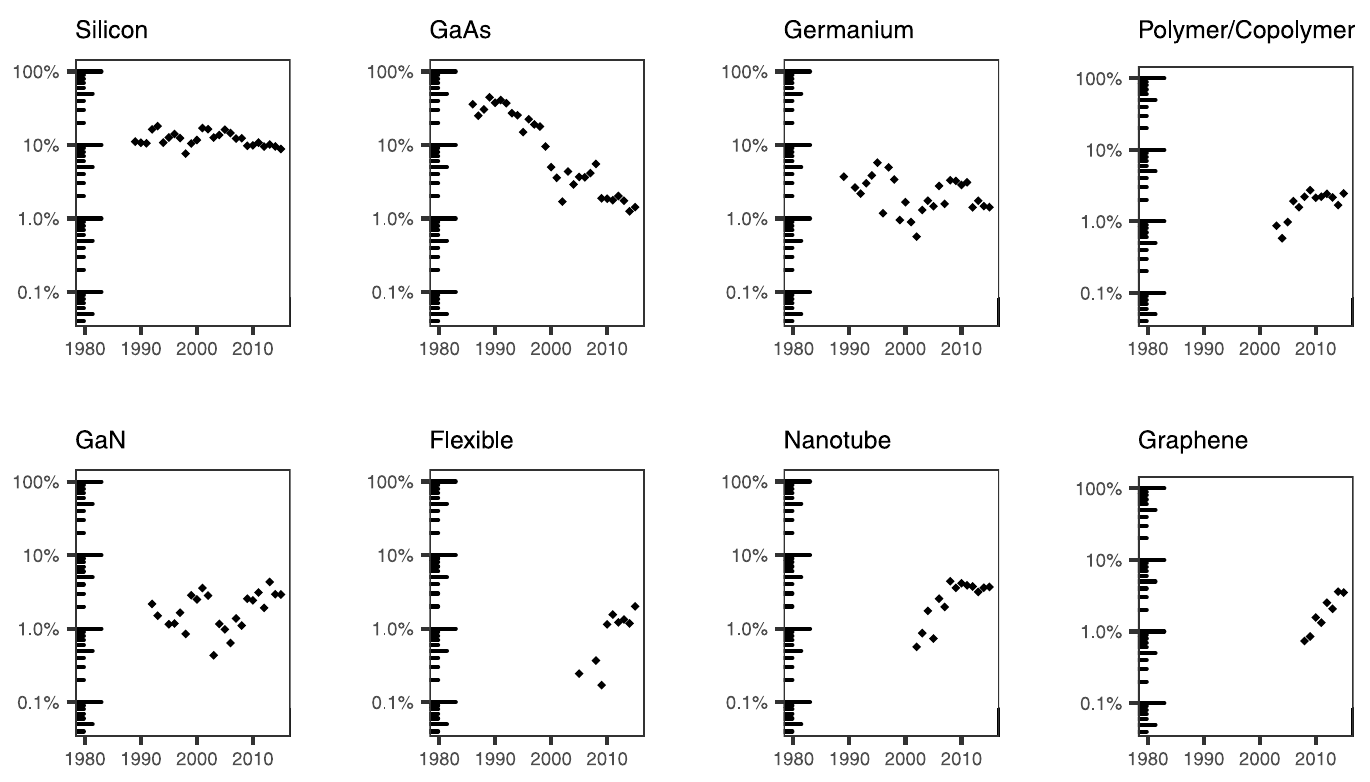
Fig 9. Percentage of ALD papers containing a specific word pertaining to substrate materialsin the titles.